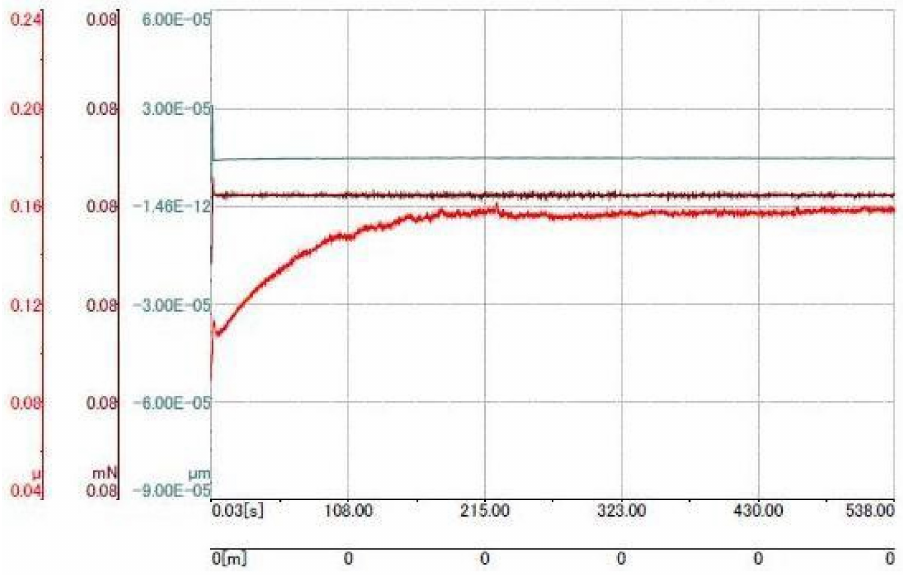
Figure 8. Results of wear tests for the chitosan of DD 87% coating: red color—change in friction coe ffi cient with test time, green color—change in penetration depth ( µ m), and brown color—load force, which was constant during the test.